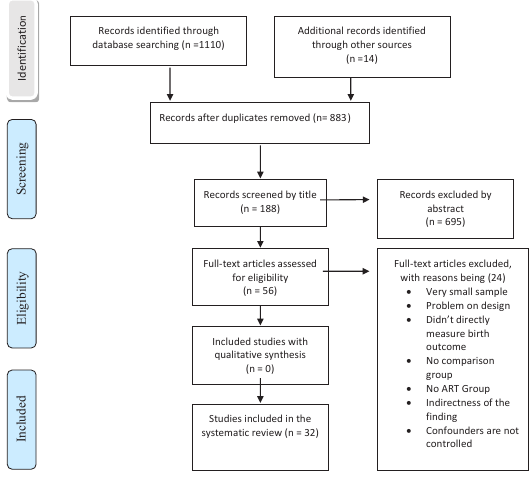
Figure 1. Flow Diagram of the systematic review process, ART and pregnancy outcome, November 2013 (adopted from PRISMA tool) [54]